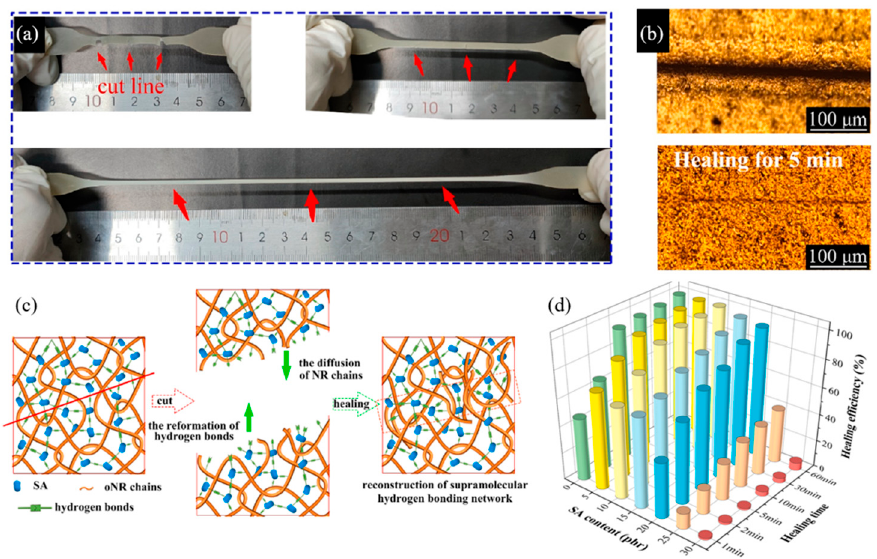
Figure 14. The self-healing photograph and microscope ( a , b ), self-healing mechanism ( c ), and healing efficiency ( d ) of SA crosslinked oNR supramolecular networks [76]. Adapted from [76], Copyright 2021, with permission from Elsevier.